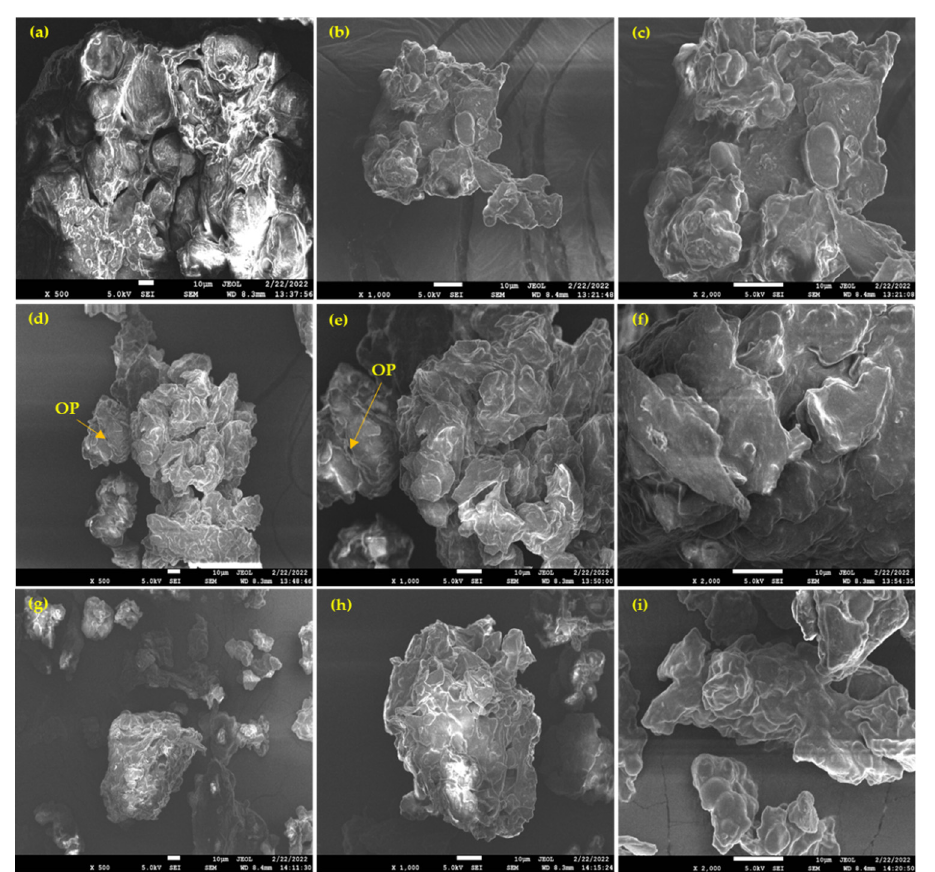
Figure 3. Morphology of raw ( a – c ), germinated ( d – f ), and hydrothermally cooked ( g – i ) Nitta bean flours. OP—oval shape protein.